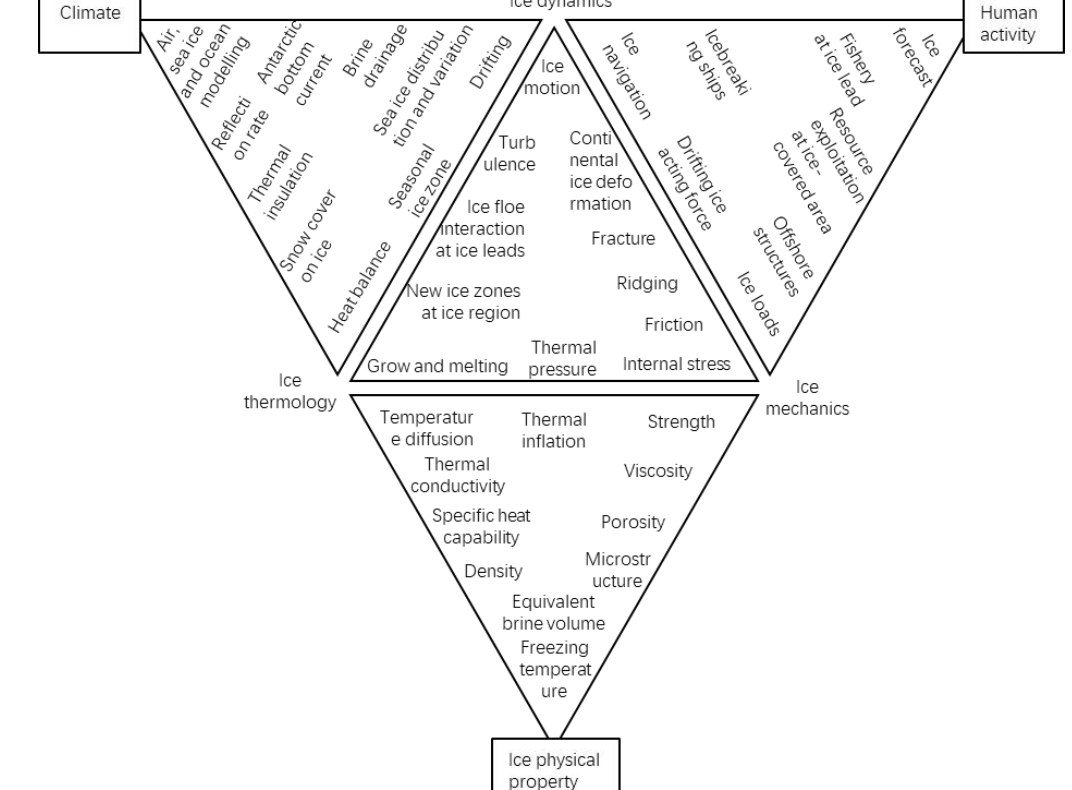
Figure 2. Relationships between the research fields related to ice (modified from Ref. [4]).